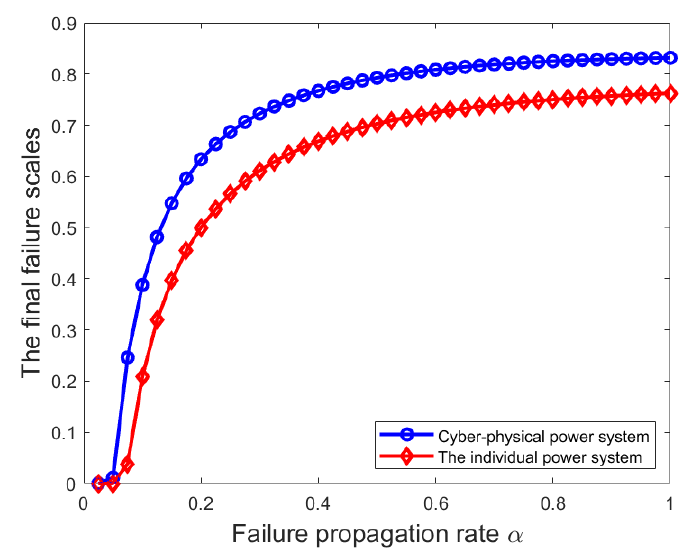
Figure 13. Comparison of final failure scales.